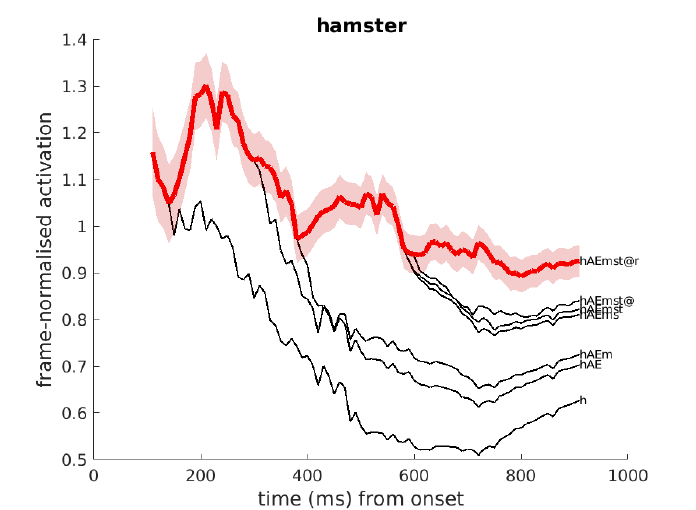
Figure 4. Example of DIANA’s activation over time corresponding to the input English word ‘hamster’. The figure shows the activations of the competing word forms ‘ham’ and ‘hamster’ and their cohorts. The competing forms are denoted (using SAMPA) at the right-hand side. A few competitors overlap with each other until stimulus